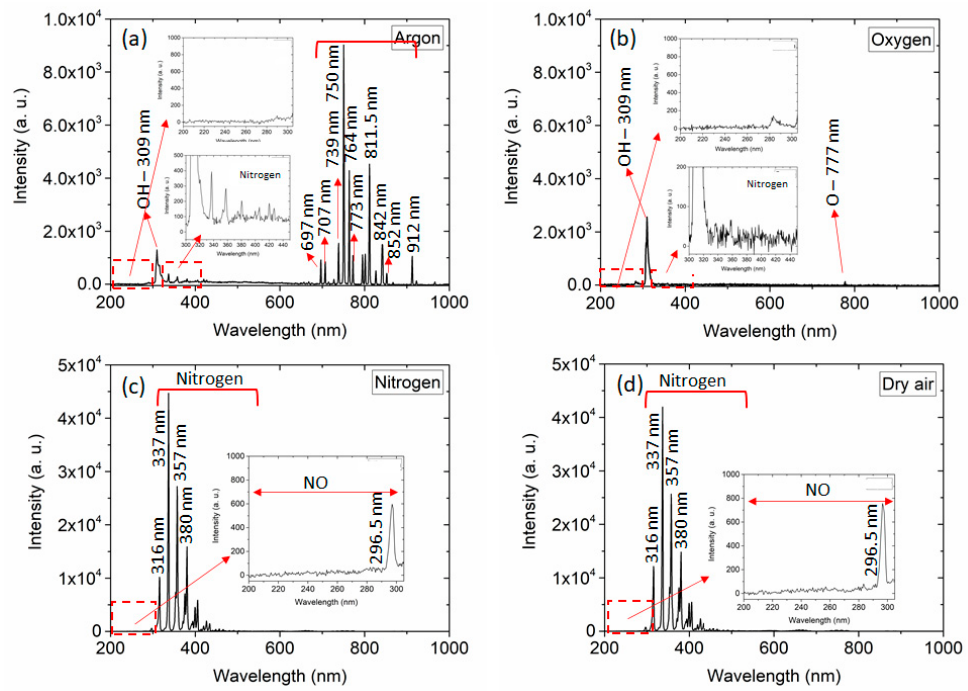
Figure 3. Optical emission spectroscopy for ( a ) argon, ( b ) oxygen, ( c ) nitrogen, and ( d ) dry air DBD plasmas in the gas